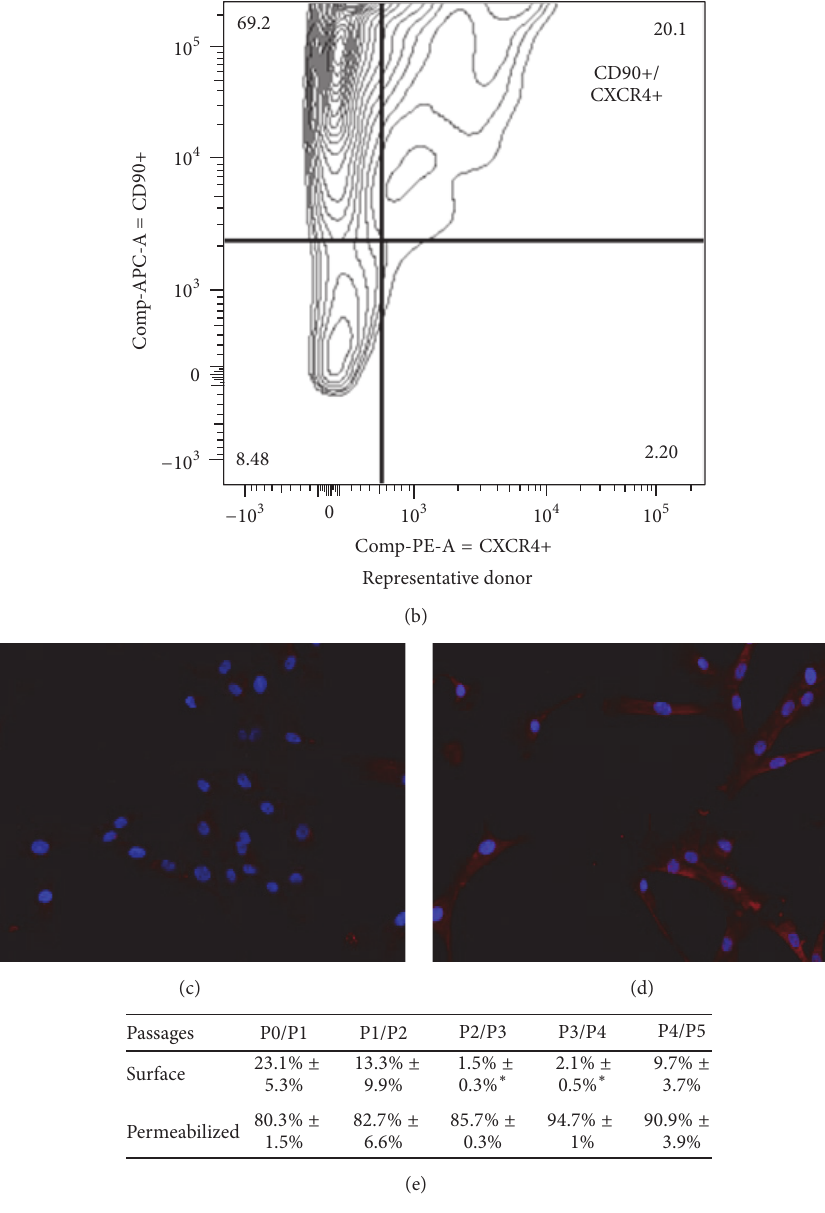
Figure3:CXCR4expressionofADHLSCs.(a)CXCR4surfaceandinternalizedexpressionfrompassages1to4byflowcytometry.(b)Contour plot of double staining for CD90 and CXCR4 at passage 1. Representative immunofluorescence pictures of CXCR4 staining at passage 4 for permeabilized (d) and nonpermeabilized (c) ADHLSCs. (e) Cell surface and intracellular CXCR4 expression ( ± standard error of the mean) from passages 1 to 5 ( 𝑛 = 4 donors); significant differences have been found on the surface expression between P0/P1 and P2/P3 and P3/P4 ( ∗ 𝑃 < 0.05